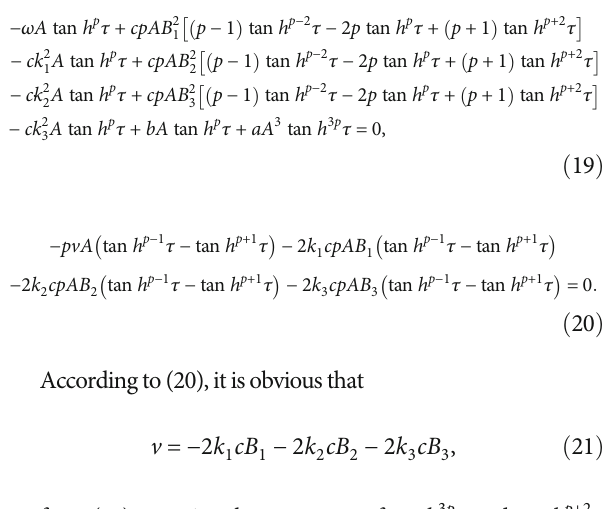
Figure 2: (Color online) The solitary wave solution (13) of Equation (1) with suitable parameters: a = 3 , b = ffiffiffi p 2 . (a) Perspective view of the solitary wave solution of the imaginary part. (b) The overhead view (density plot) of the y = z = 0 , and n = − solitary wave solution of the imaginary part. (c) The wave propagation pattern of the wave along the x -axis of the imaginary